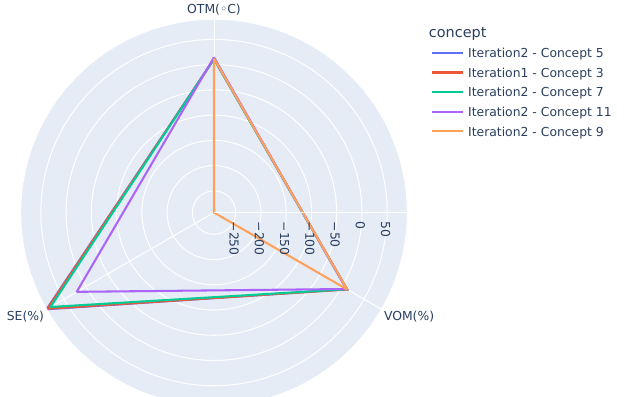
Figure 6. Comparing concepts of both the iterations (after receiving chunk 2 and 3, Iteration 1 and 2, respectively) using the relationship between OTM, VOM, and SE when 10 ◦ C < OTM < 15 ◦ C. Note that some of the concepts in the legend are not visible in the image due to